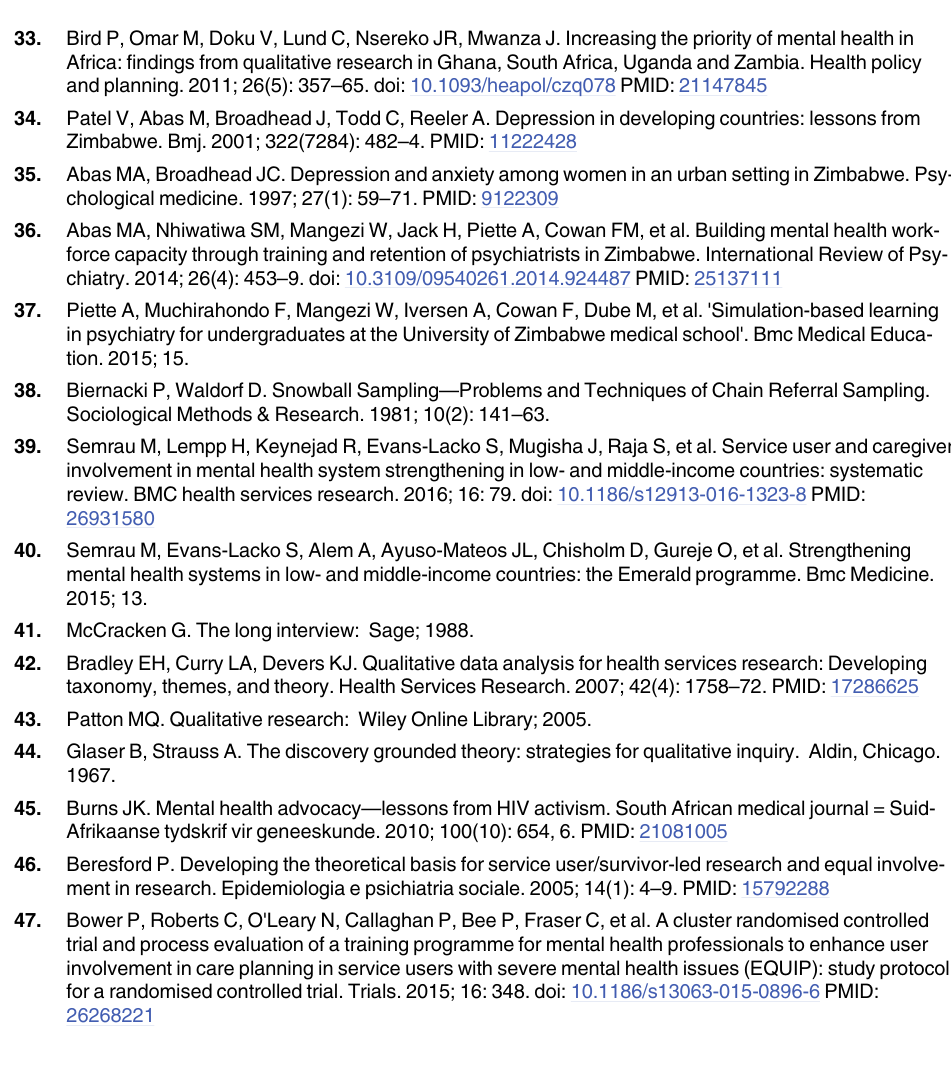
PLOS ONE | DOI:10.1371/journal.pone.0161860 September 8,